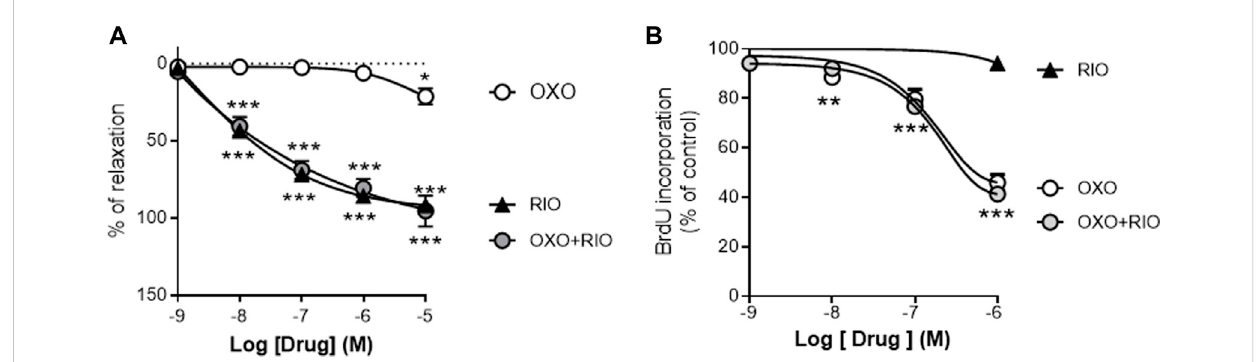
FIGURE 1 Vasodilator and antiproliferative effects of the TAK-1 inhibitor 5Z-7-oxozeaenol and the soluble guanylate cyclase activator riociguat in healthy rat pulmonary arteries. (A) Concentration-dependent relaxant effects of 5Z-7-oxozeaenol (OXO) and riociguat (RIO) in the absence or presence of OXO (1 µM) in PA stimulated with 0.1 µM of U46619. (B) Concentration-dependent effects of RIO and OXO in the absence or presence of RIO (1 µM) in the proliferation induced by 10% of FCS in PASMCs. n = 6-7 vascularrings (A) or experiments run in triplicate (B) for each group * p < 0,05 versus control (two-way ANOVA followed by Dunnett ’ s post hoc